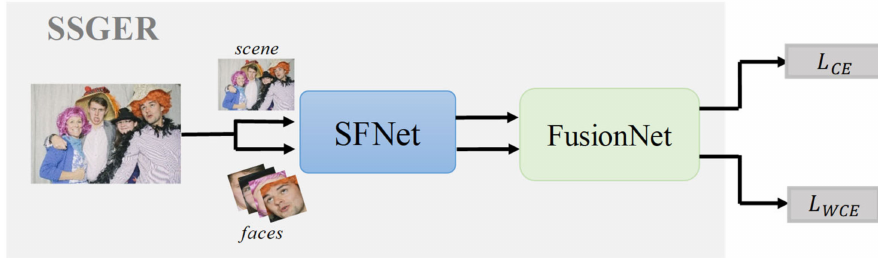
Figure 1. The overview of SSGER framework.